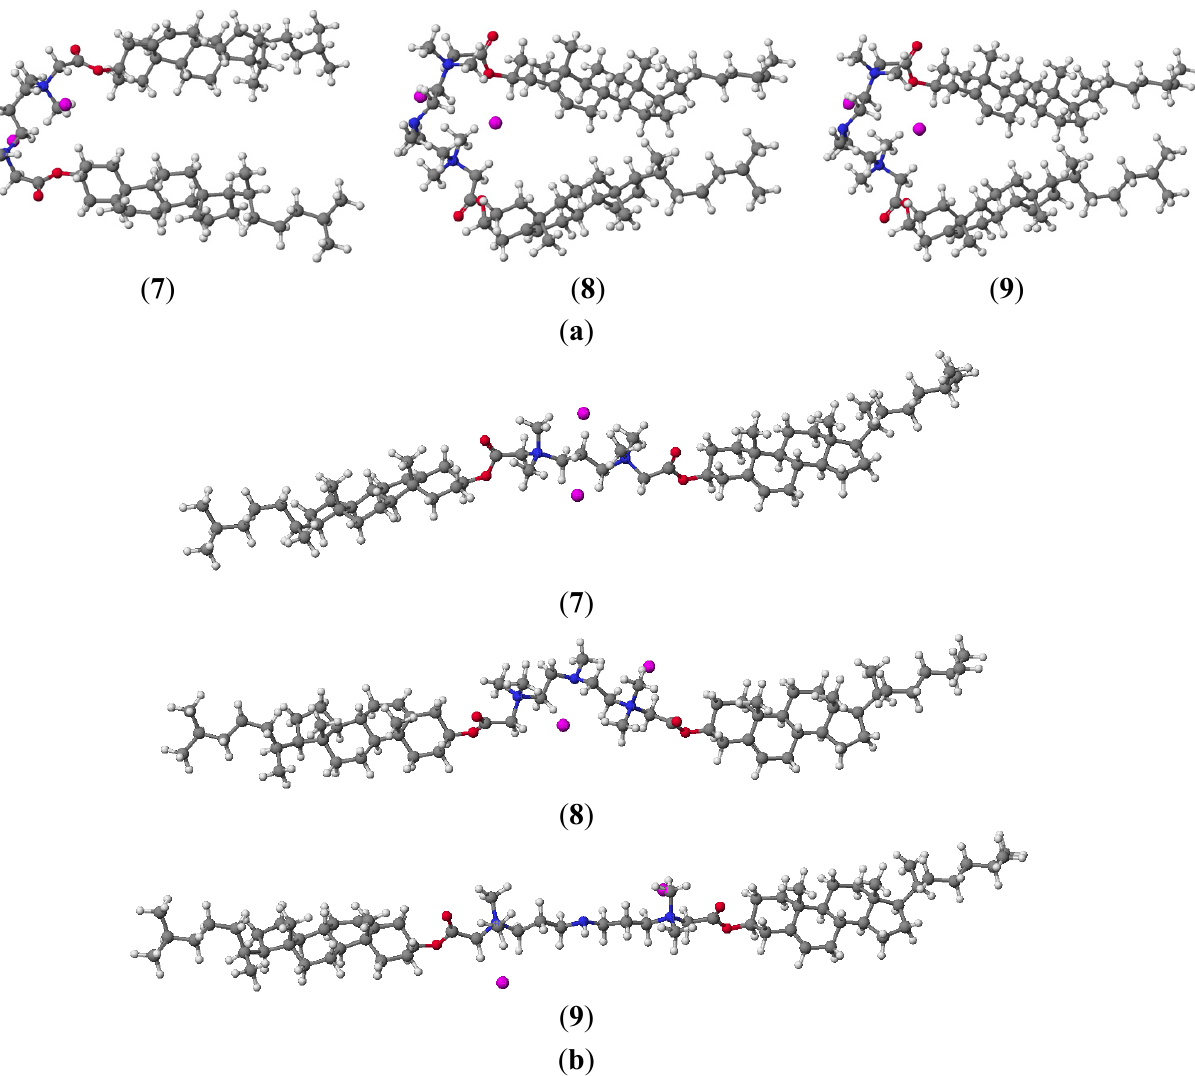
Figure 5. The syn ( a ) and anti ( b ) conformers of compounds 7 , 8 and 9 calculated by the PM5